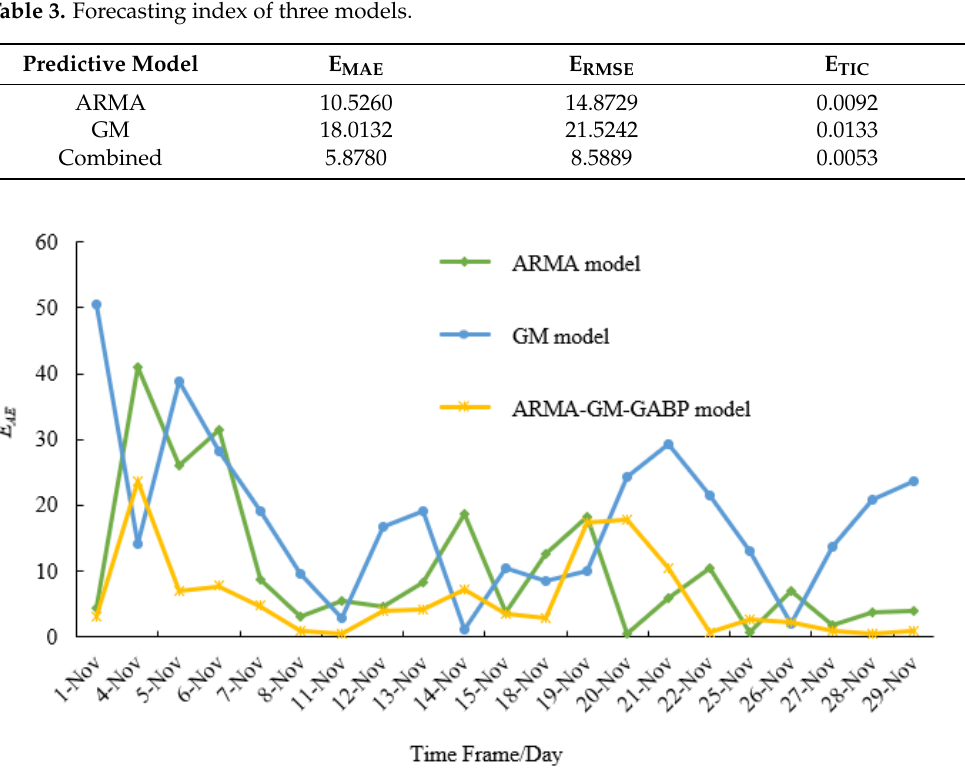
Figure 7. EAE of three prediction models.